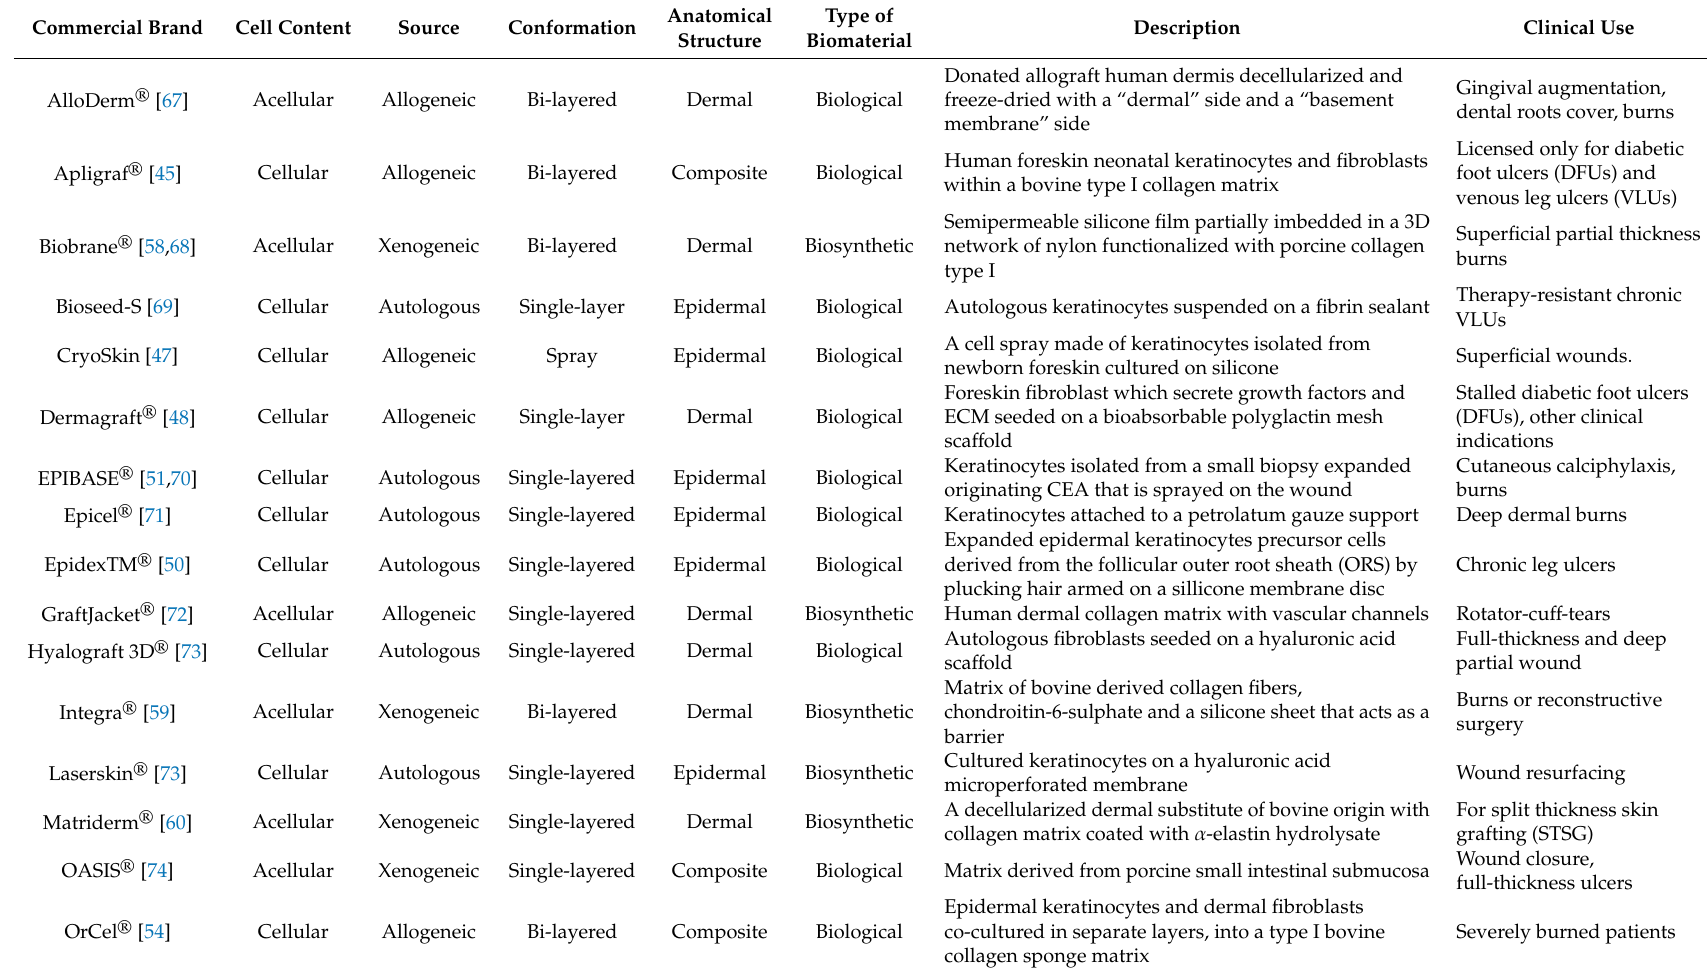
Table 2. Commercially Skin Substitutes 1